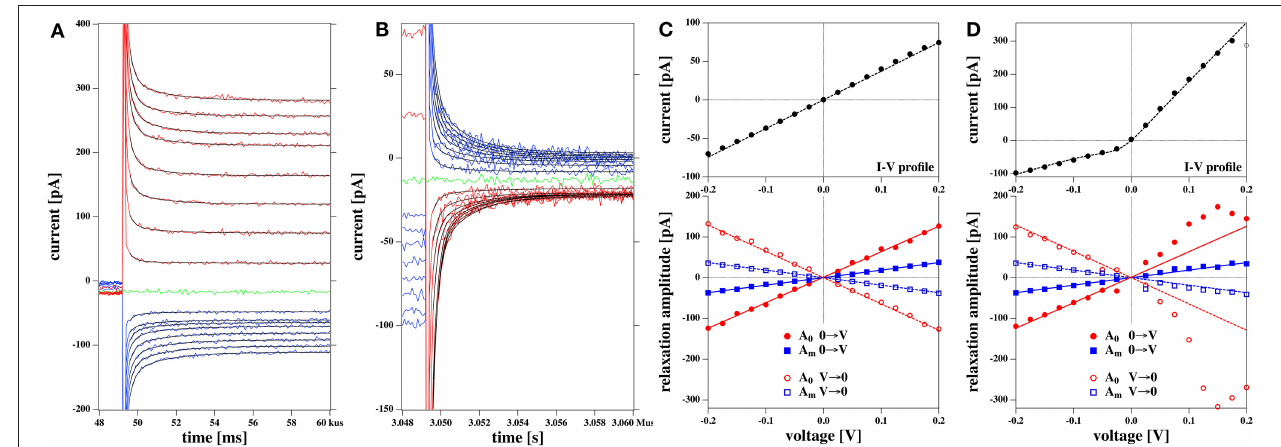
FIGURE 12 | Relaxation processes corresponding to the I-V profiles shown in Figures 5C,D : (A) Relaxation processes after a jump from 0 volt to a fixed voltage for the rectified I-V profile shown in Figure 5D . The thin black lines represent the fits to a biexponential function. V. (B) Relaxation processes after jump from a fixed voltage V to zero volts for the rectified I-V profile shown in Figure 5D . (C) Bottom panel: The fit parameters of the relaxation processes corresponding to Figure 5C . The top panel shows the corresponding I-V relation Both the amplitudes of the fast and the slow process, A 0 and A m are linear as is the IV profile. (D) Bottom panel: The fit parameters of the relaxation processes corresponding to Figure 5D . Here, A m is linear in voltage and equal in magnitude in both experiments (blue lines). Amplitude A 0 displays a non-linear voltage dependence for the rectified I-V profile (right). The solid lines at the bottom are the same in (C,D) . In (D) they serve as a guide to the eye to demonstrate the non-linearity of the voltage dependence for amplitude A 0 . The current relaxation profiles in (A,B) were not corrected for a slight current offset from